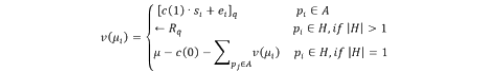
Table 2. Select parameters for Brakerski/Fan-Vercauteren homomorphic encryption. 16,38416,384Polynomial